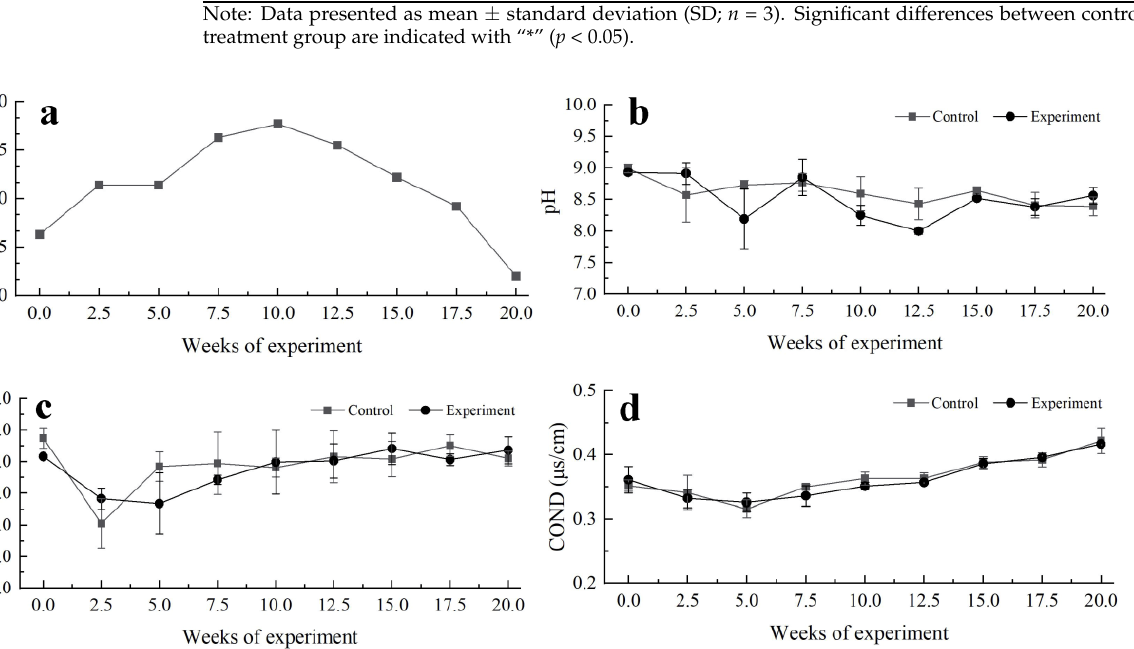
Figure 2. Changes of water quality parameters in the control and treatment group during the exper- iment. ( a ) TAN; ( b ) NO3-N; ( c ) NO2-N; ( d ) PO4-P. Vertical bars represent the mean ± SD ( n = 3). Figure 3. Changes of water quality parameters in the control and treatment group during the exper- iment. ( a ) TN; ( b ) TP; ( c ) COD. Vertical bars represent the mean ± SD ( n = 3).